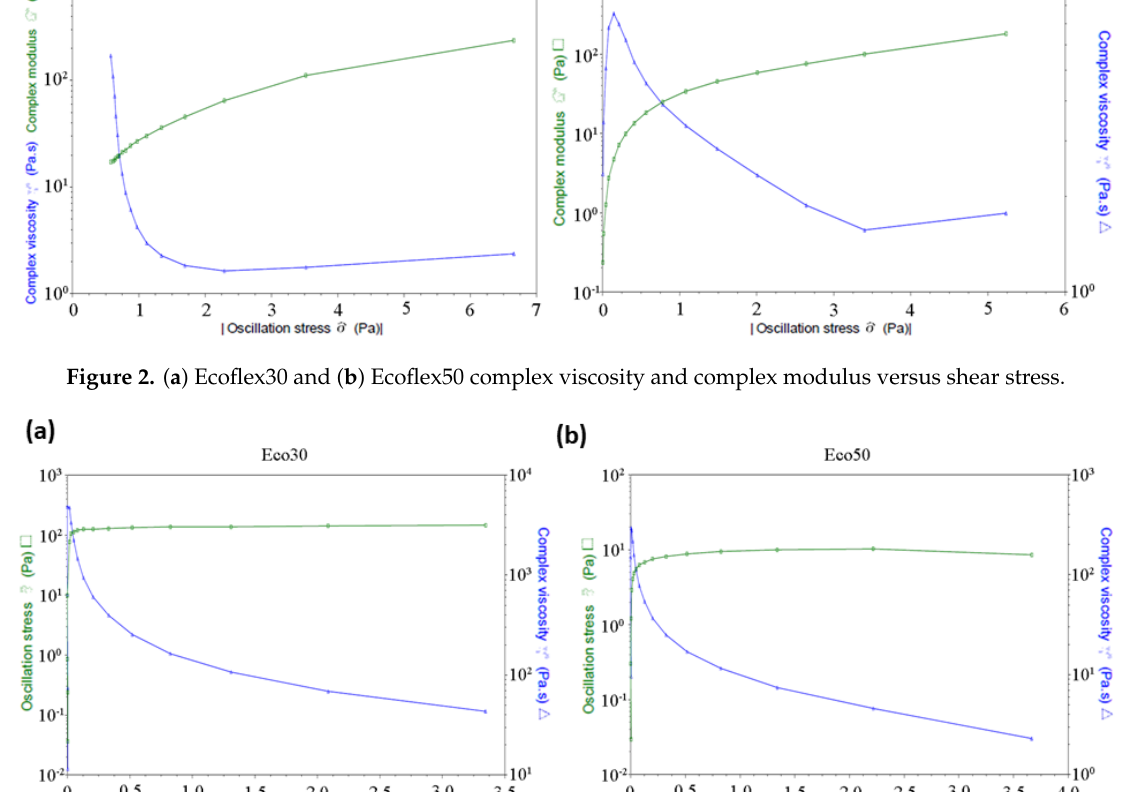
Figure 2. (a) Ecoflex30 and (b) Ecoflex50 complex viscosity and complex modulus versus shear stress.